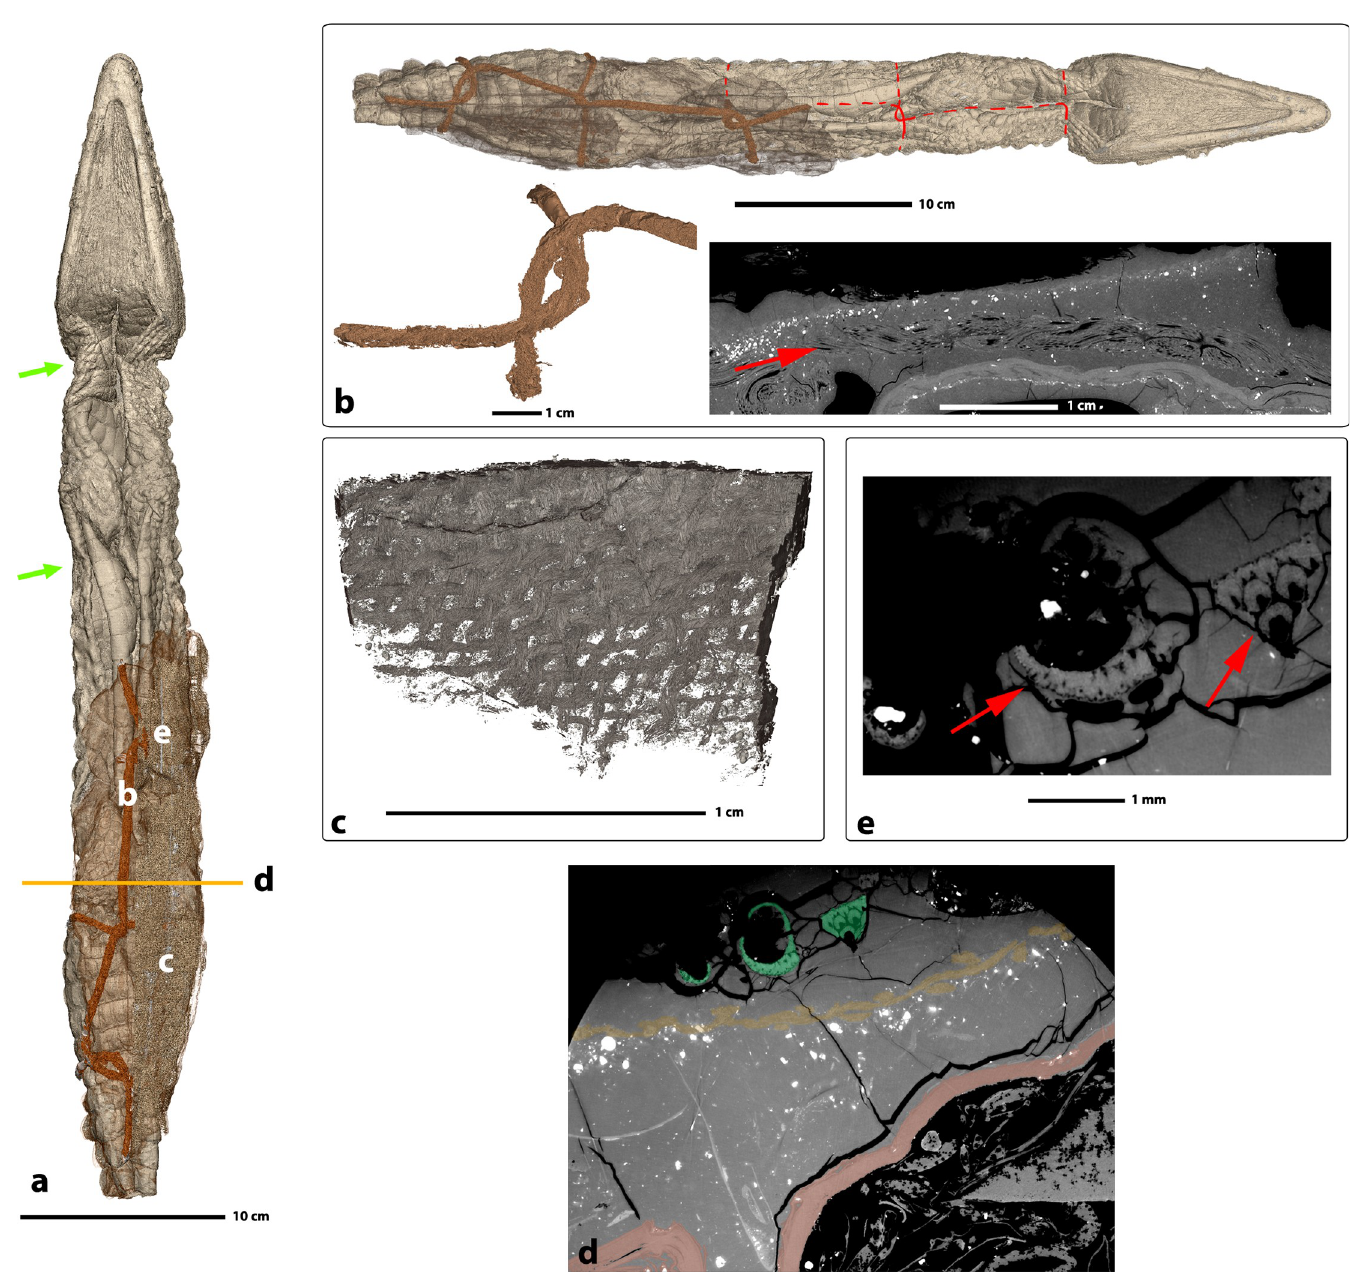
Fig 5. Details of the inclusions present inside the crocodile mummy. a. general 3D rendering of the inclusions and their locations, b. 3D rendering and tomographic slice of the rope embedded in the balm (dark brown) and putative location of the missing parts of the rope inferred from the constrictions of the skin (green arrows), c. 3D rendering of the fabrics present inside the balm, d. tomographic slide showing the denser mineral inclusions (white spots in balm) below a layer of fabric (highlighted in pastel yellow) and the date palm leaves in green, e. tomographic slide of the date palm ( Phoenix dactylifera ) leaves rachis.